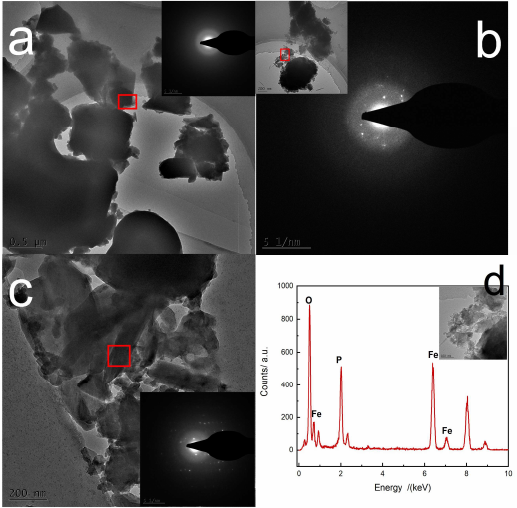
Figure 6. TEM images of FePO 4 ·2H 2 O at ( a ) initial, ( b ) 150 min and ( c ) end of reaction, respectively; ( d ) typical EDS spectrum of initially produced precipitate. ( d ) typical EDS spectrum of initially produced precipitate.